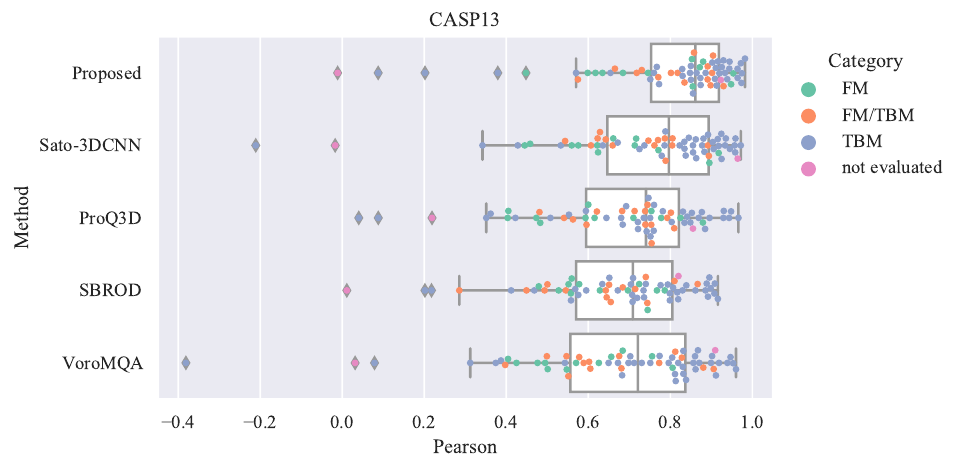
Figure A1. Swarm plot and box plot of the Pearson correlation coefficient for each target on CASP13. The x-axis represents the Pearson correlation coefficient, and the y-axis represents the method. A point represents a target, and the color of the point represents the category of the